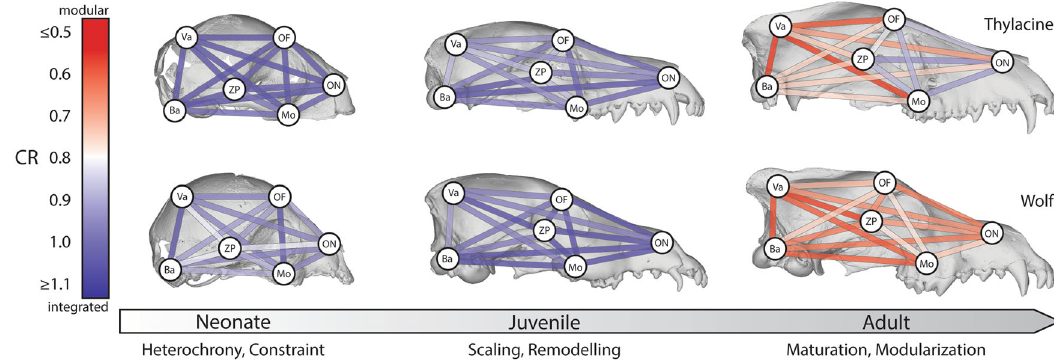
Fig. 4 Network diagrams of module covariation patterns during ontogeny. Pairwise covariance ratio (CR) coef fi cients between cranial landmark modules (see Table S2) for thylacine and wolf on neonate, juvenile, and adult 3D rendered skulls. Low CR values are expressed by warm colors, indicating modularity, whereas cool colors represent high CR values, suggesting integration. Neonatal and juvenile modules show high CR ratios (integration). The adult thylacine retains an integrated facial skeleton, while the adult wolf skull becomes modular. Ba basicranium, Mo molar, OF orbitofrontal, ON oral-nasal, Va vault, ZP